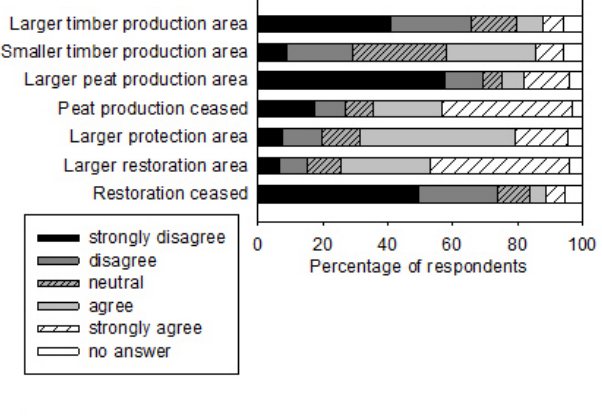
Fig. 2 . Distributions of opinions toward attribute levels describing land-use options, used in the latent class model (LCM). Number of respondents =